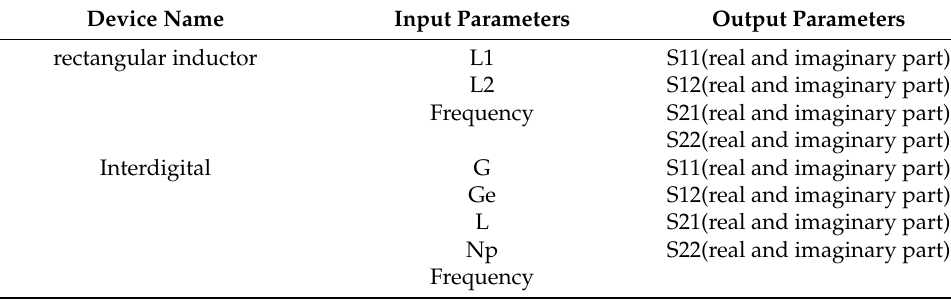
Table 3. Input and output of deep neural network.